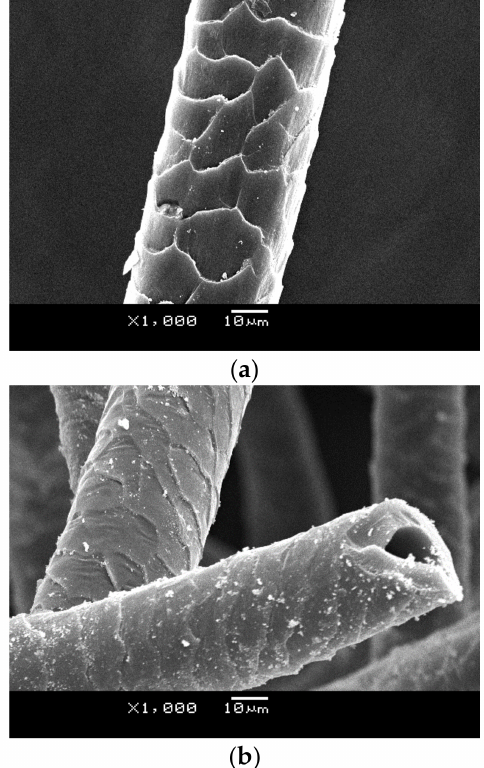
Figure 2. A 1000 × magnification SEM image of the wool felt ( a ), and the stabilized felt ( b ).